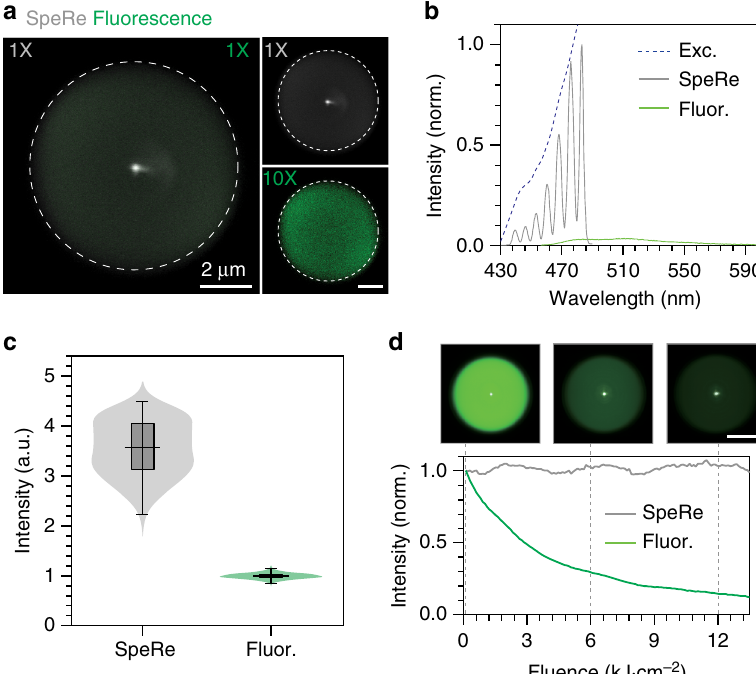
Fig. 3 Comparison of a re fl ectophore with a fl uorophore. a Simultaneous spectral re fl ectance (SpeRe) and fl uorescence imaging on a fl uorescent re fl ectophore. The left panel shows the merged image of SpeRe (gray) and fl uorescence (green), measured at the same detector gain (1× for SpeRe and fl uorescence). Note that fl uorescence is nearly invisible due to its orders-of-magnitude lower brightness. The right panel separately shows SpeRe and fl uorescence images at the indicated detector gain (1× for SpeRe, 10X for fl uorescence). Scale bar, 2 μ m. b Measured spectra for re fl ectance (gray) and fl uorescence (green) with input beam focused at the centroid. Exc excitation light, Fluor fl uorescence. c Quanti fi cation of the total optical intensity in b presented as a violin plot and a box-and-whisker plot (center line, median; box limits, upper and lower quartiles; whiskers, min and max; n = 121 pixels for SpeRe; n = 2700 pixels for fl uorescence). Source data are provided as a Source Data File. d Photobleaching kinetics. A fl uorescent re fl ectophore was serially imaged by both SpeRe (gray) and fl uorescence (green). Note that fl uorescence exponentially decays over time whereas re fl ectance stays